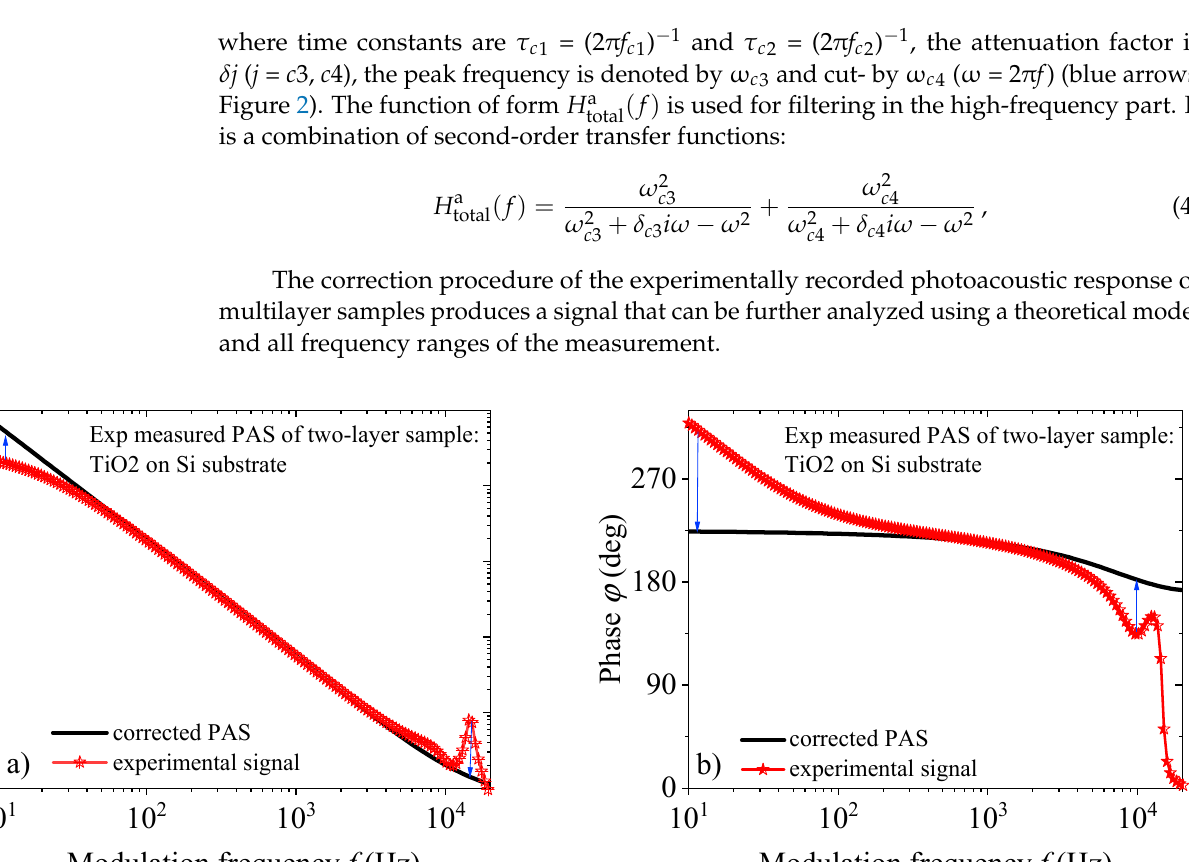
Figure 2. Frequency dependence of ( a ) amplitude and ( b ) phase of experimentally measured photoacoustic signal TiO 2 placed on Si substrate (red asterisk) and the corresponding amplitude and phase of the photoacoustic signal δ p total ( f ) (black line), correction on the instrument input (blue ar- rows).